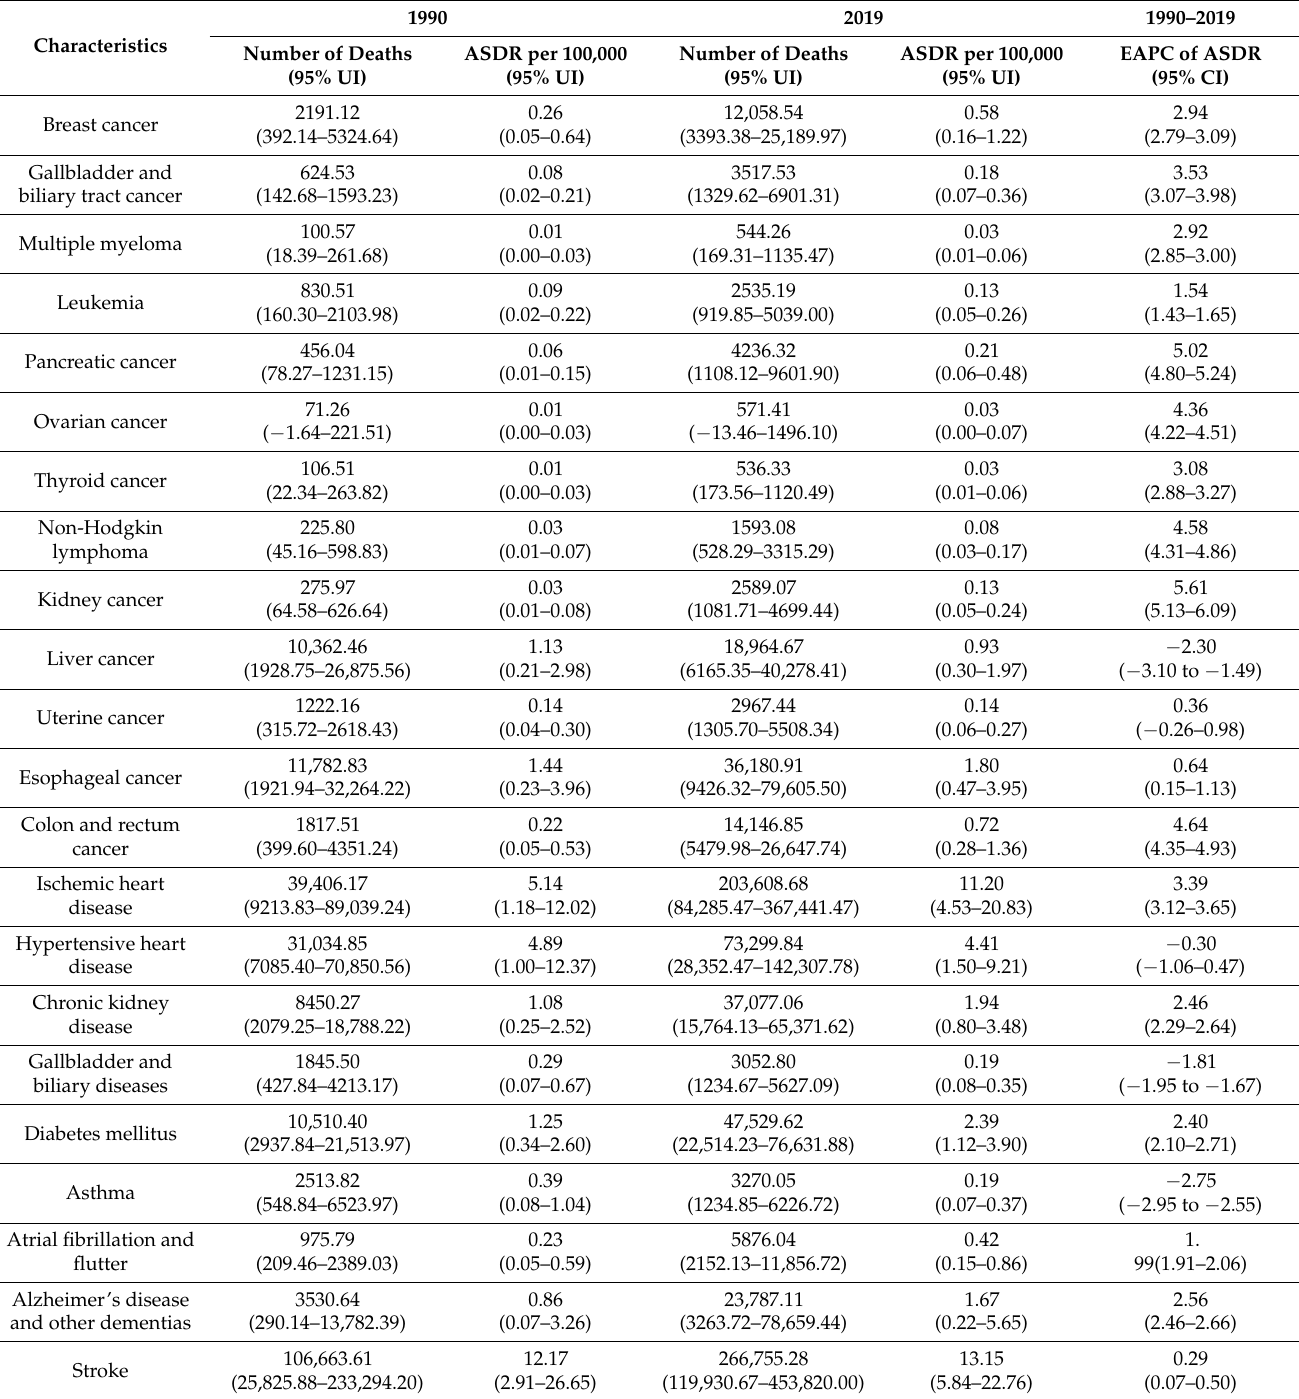
Table 1. The number of deaths and ASDR in those with high BMI in 1990 and 2019, and their temporal trends from 1990 to